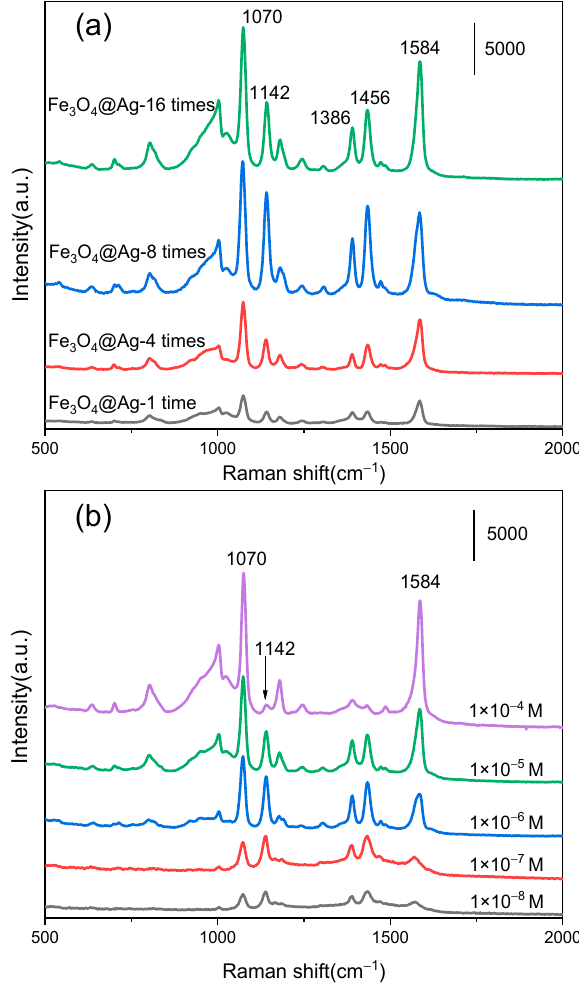
Figure 4. Raman spectra of PATP on the prepared AgMNPs with different concentrations of Ag colloid ( a ), and SERS spectra of different concentrations of PATP adsorbed on AgMNPs ( b